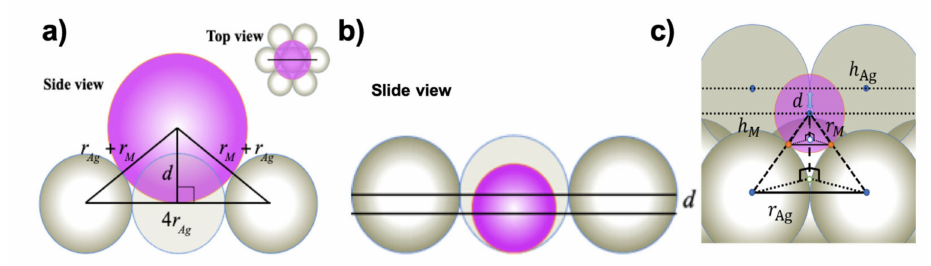
√ (cid:16) √ (cid:17) R 30 ◦ surface 3 × 3